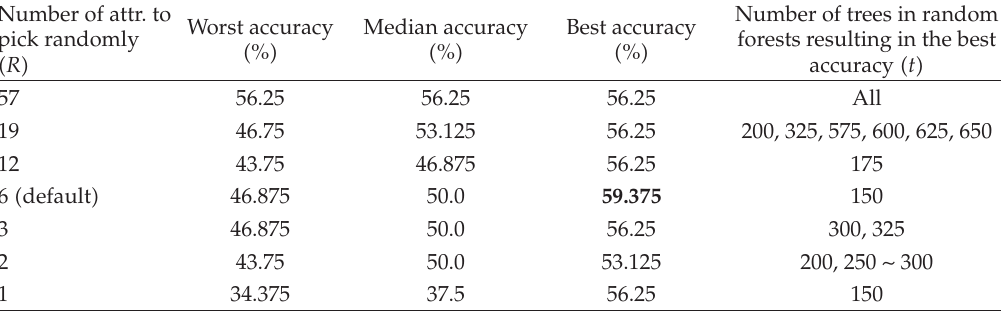
Table 17: The accuracy of random forests for the data set “lung